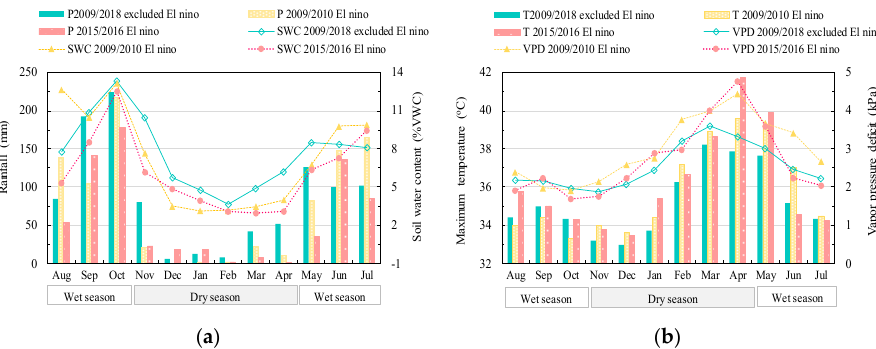
Figure 1. Comparison of climate variables between two El Niño events in 2009/2010 (yellow) and 2015/2016 (red), and 10 years (2009–2018) (green) microclimate average excluding the two El Niño events; ( a ) rainfall (p) and soil water content (SWC), ( b ) maximum air temperature (T), and maximum vapor pressure deficit (VPD).